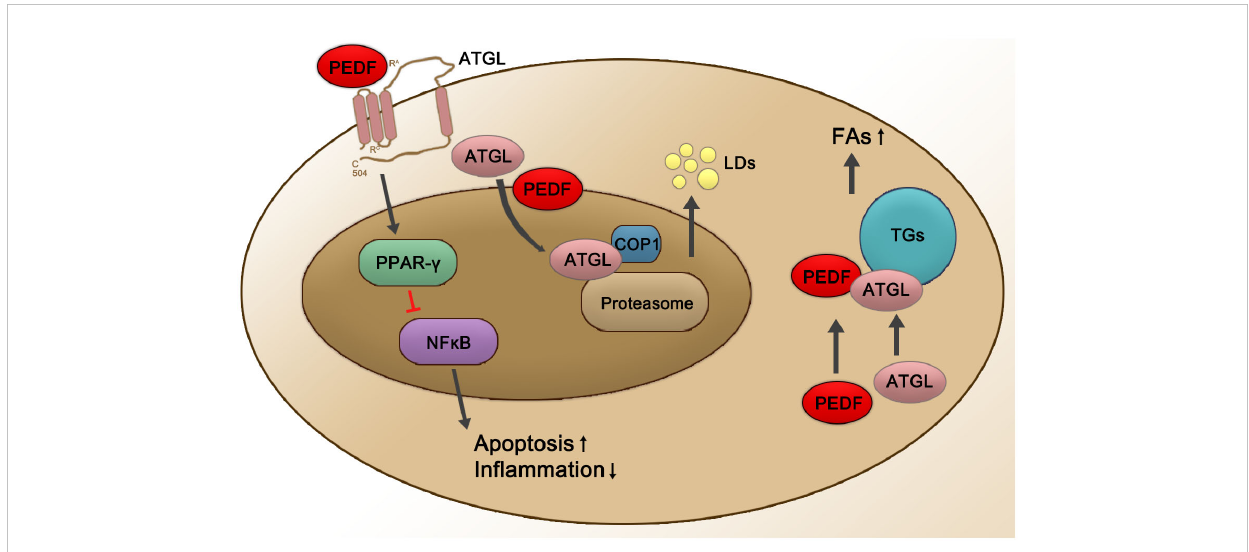
FIGURE 1 Schematic representation of PEDF-activated ATGL signaling. PEDF binds to the cell surface membrane receptor ATGL, which leads to the upregulation of PPAR g and then suppresses NF ĸ B at the transcriptional level, subsequently leading to decreased in fl ammation and an increased apoptosis rates. PEDF also enhances nuclear import of +predominantly cytosolic ATGL protein for its subsequent proteasomal degradation in the nucleus, thereby diminishing ATGL protein stability in a COP1-dependent manner, which enhances the release of LDs. In addition, the PEDF-ATGL interaction promotes the hydrolysis of TGs and the release of FAs. Red lines represent inhibited pathways, and black arrows show activated pathways. PPAR- g , peroxisome proliferator-activated receptor g ; NF ĸ B, nuclear factor ĸ B; COP1, constitutive photomorphogenic 1; LDs, lipid droplets; TGs, triglycerides; FAs, fatty